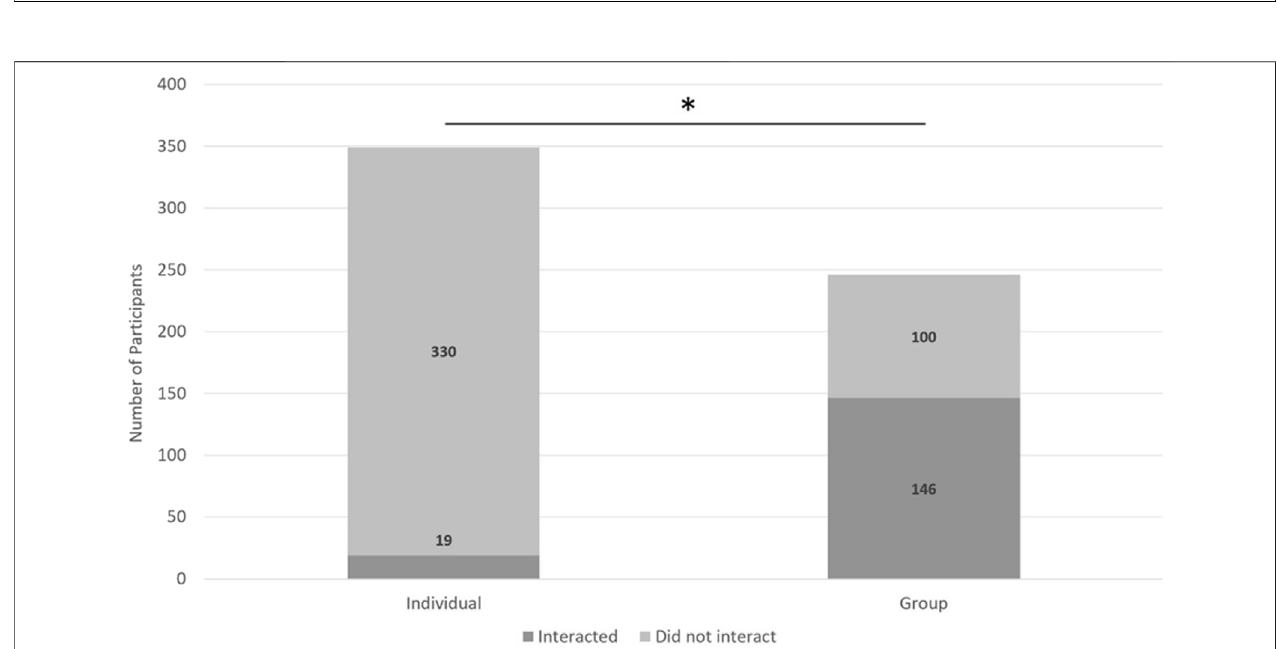
FIGURE 7 | A description of the results from H1b. Asterisks indicate groups were more likely to non-verbally interact than individuals.